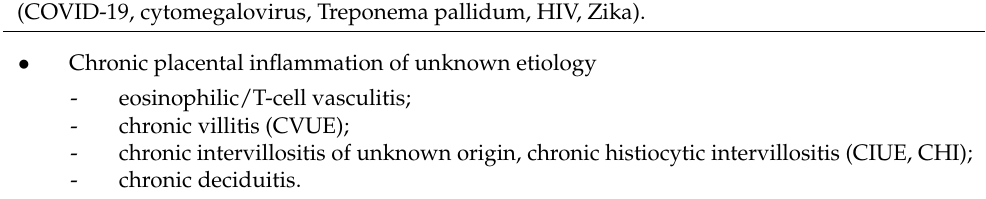
Table 1. Chronic placental